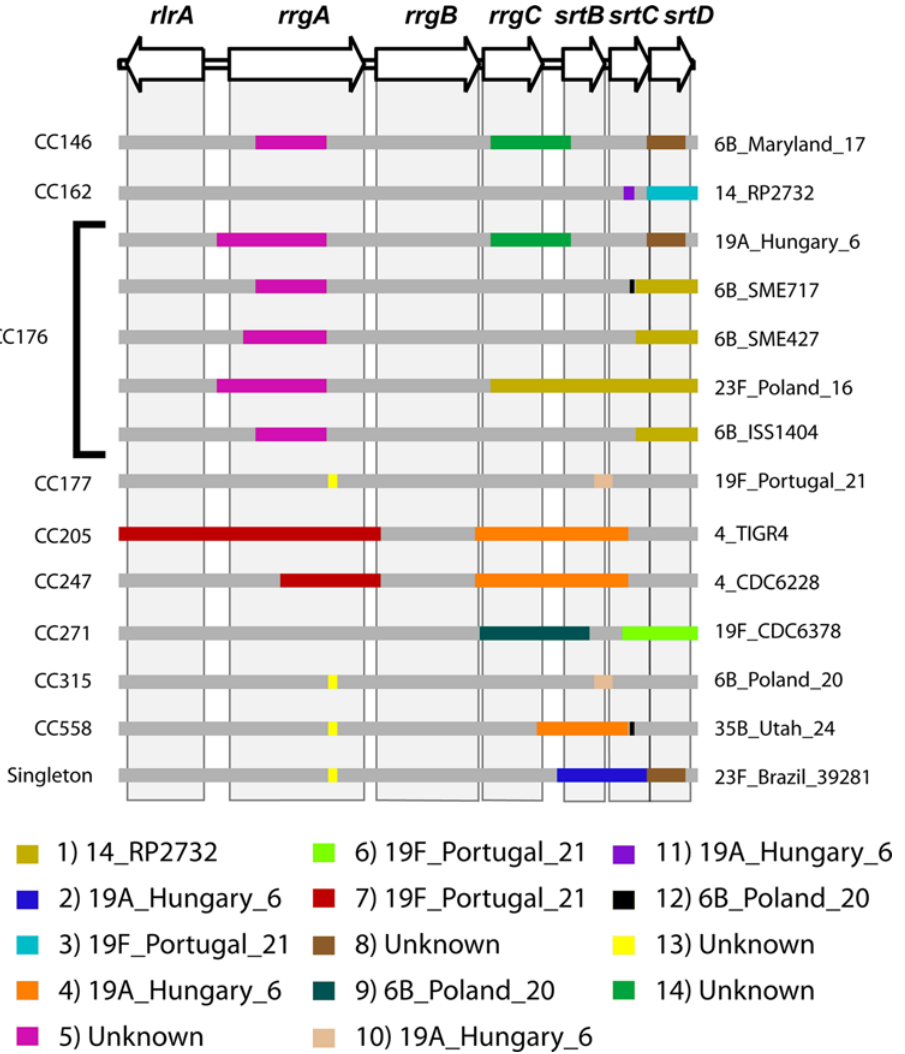
Figure 7. Schema of recent recombination events. Schematic representation of the main recent recombination events occurred within a representative subset of the sequenced strains. Each line represents a recombinant sequence, and color boxes indicate the insertion of a foreign sequence. Colors represent each unique insertion, and the name of the putative originating strain is reported in the color legend. Gray shaded areas mark the position of the ORFs on the recombinant sequences. Table S1. Additionally, the genetic sequence encoding for the rlrA islet were extracted from the genomes of the strains SP9-BS68 and SP18-BS74 downloaded from the NCBI Web site (http://www. ncbi.nlm.nih.gov), and from the genomes of strains TIGR4 and 670 downloaded from the TIGR web site (http://www.tigr.org). rlrA islet sequencing TIGR4 [37] and 670 rlrA nucleotide sequences were analysed and a set of 22 oligonucleotides matching in homologous regions inside the islands was designed. Sequences were obtained by use of an ABI 3730xl DNA Analyzer and assembled with Vector NTI 9.1. Multi Locus Sequence Typing (MLST). MLST was performed as previously described [38]. Briefly, internal fragments of the aroE , gdh , gki , recP , spi , xpt and ddl genes were amplified by PCR directly on the bacteria using the primers pairs indicated at http:// were obtained by use of an ABI 3730xl DNA Analyzer. Alleles from the MLST website (http://spneumoniae.mlst.net) were